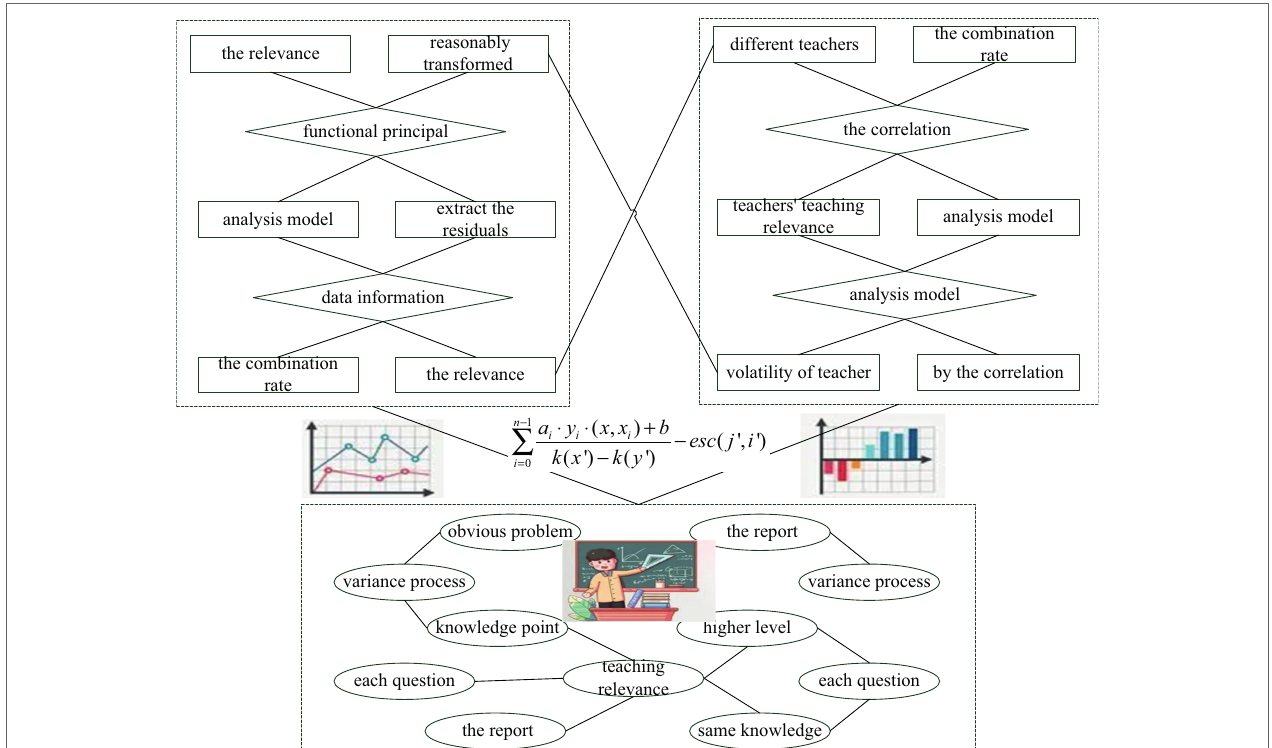
FIGURE 1 | Mutual information mechanism of teachers’ teaching psychological behavior